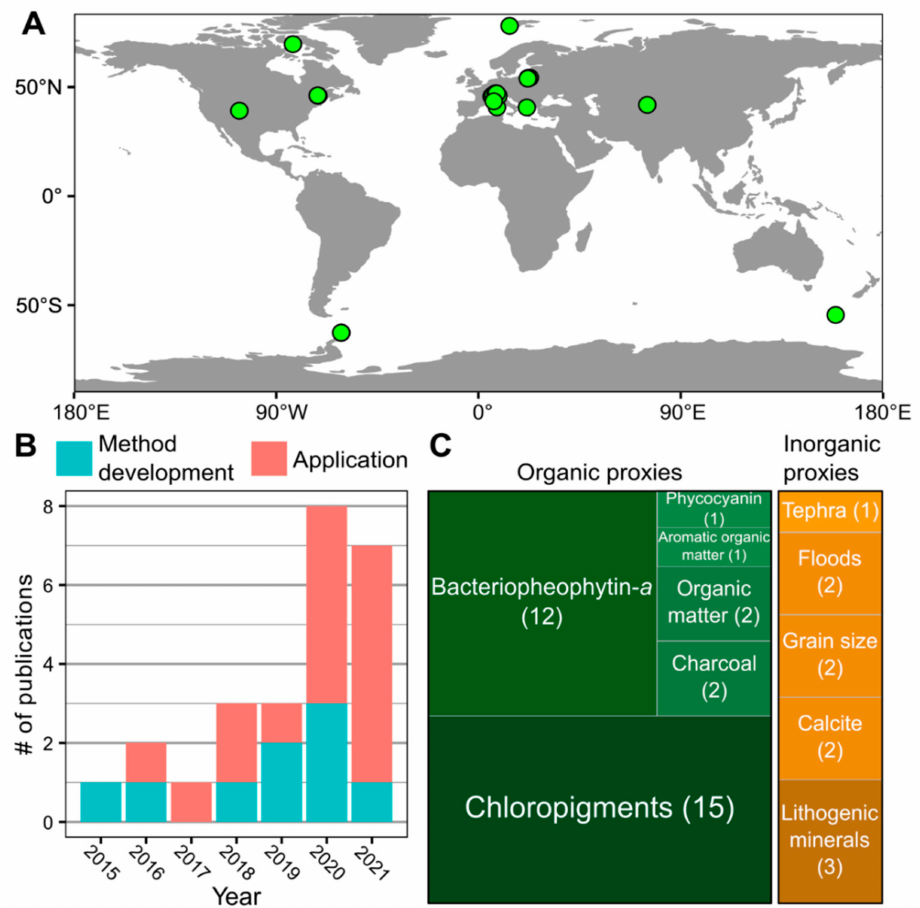
Figure 3. Summary of published hyperspectral imaging datasets from lake sediments in peer- reviewed literature (Table S1). ( A ) Map of study sites with published HSI datasets from lake sediments. ( B ) Number of publications by year showing increasing trend since 2015 ( n = 25). ( C ) Summary of publications reporting different sedimentary variables from HSI scanning of lake